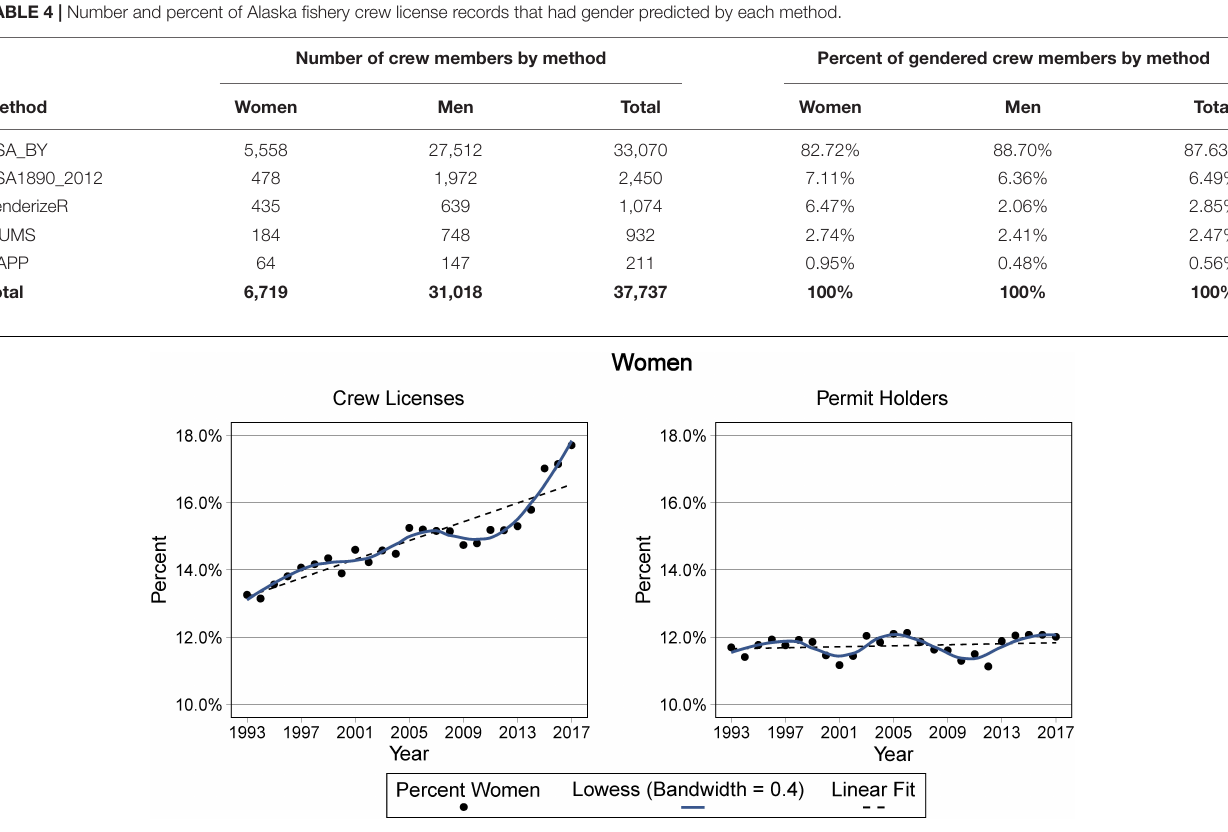
FIGURE 3 | The percent of women crew license holders and permit holders from 1993 to 2017. The points represent the percent of annual participants, the black dashed lines are the linear fit and the blue solid lines the locally weighted scatterplot smoothing (LOWESS) fit curve with a 0.4 bandwidth.